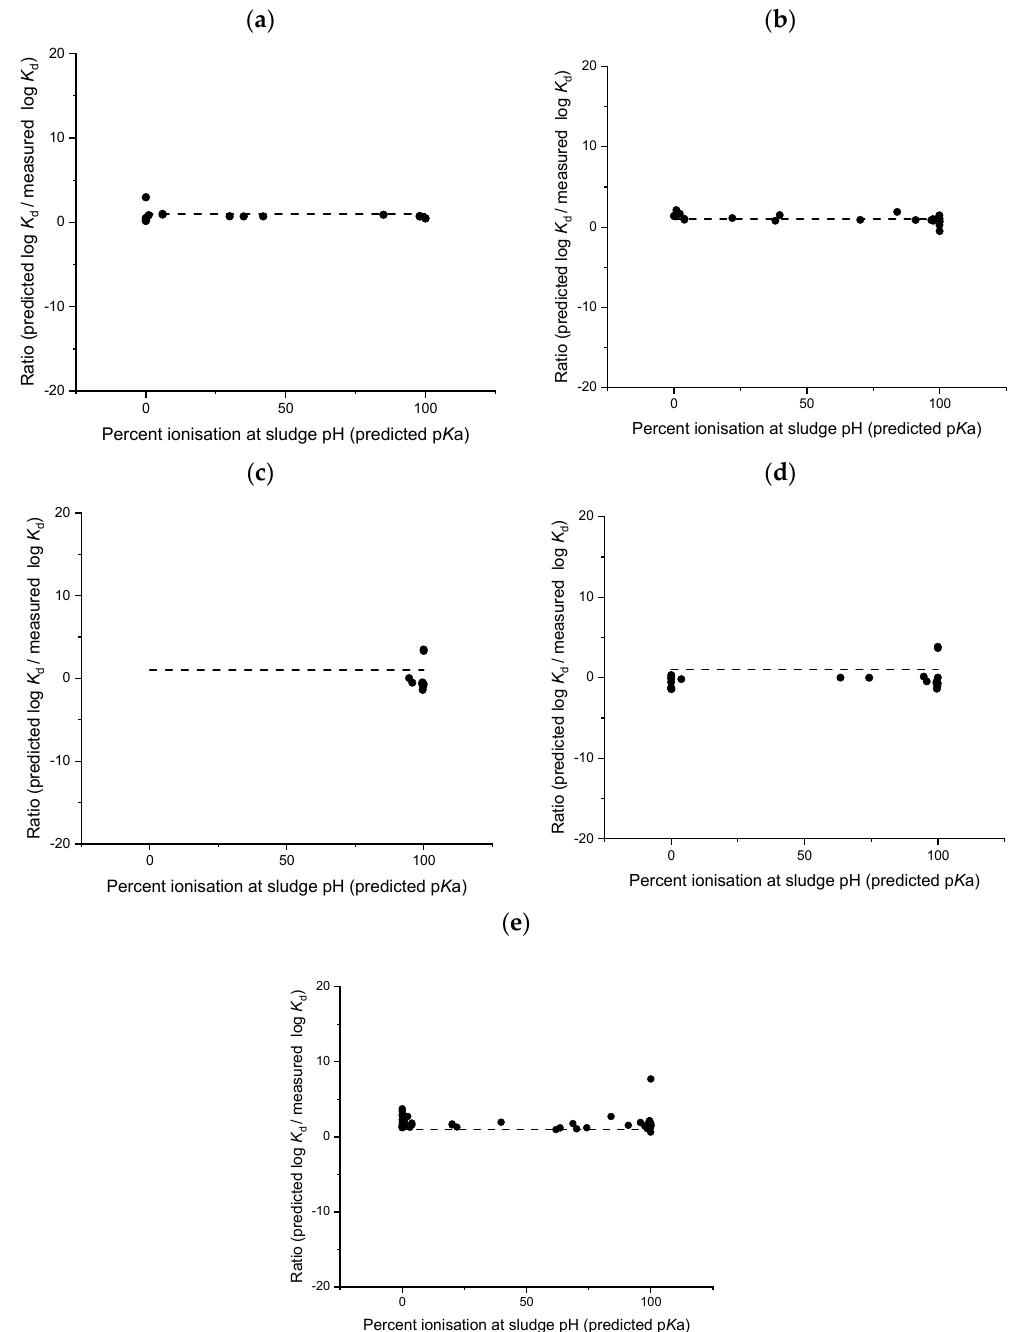
Figure 6. Ratio between predicted and measured sludge sorption coefficients and relationship to percent ionisation of test compound, Franco et al.[33] acids ( a ); Franco et al. [33] bases ( b ); Sathymoorthy and Ramsburg [32] ionised acids ( c ); Sathymoorthy and Ramsburg [32] acids ( d ); Berthod et al. [34] ( e ).